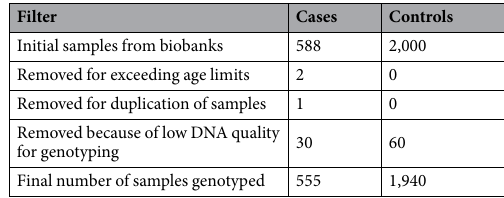
Table 3. Filtering process for genotyped samples.